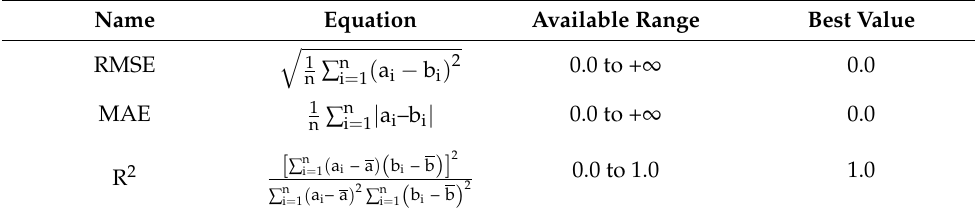
Table 3. Description of the evaluation criteria used in this